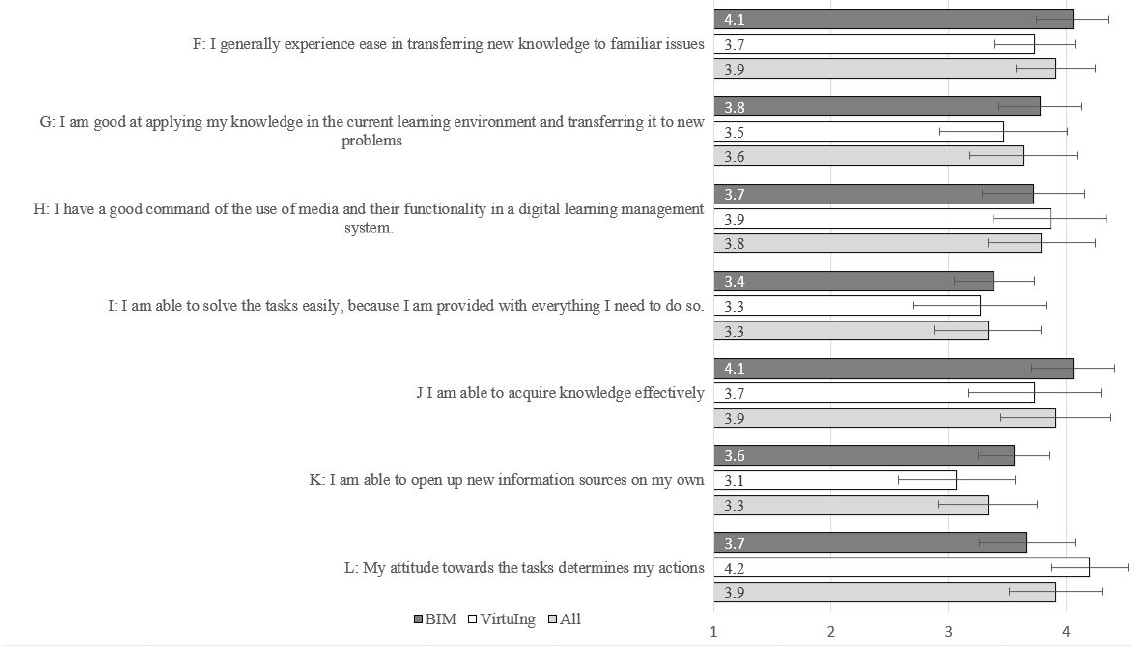
Figure 3. Items regarding learning and cohort ( n = 11, mean from 3